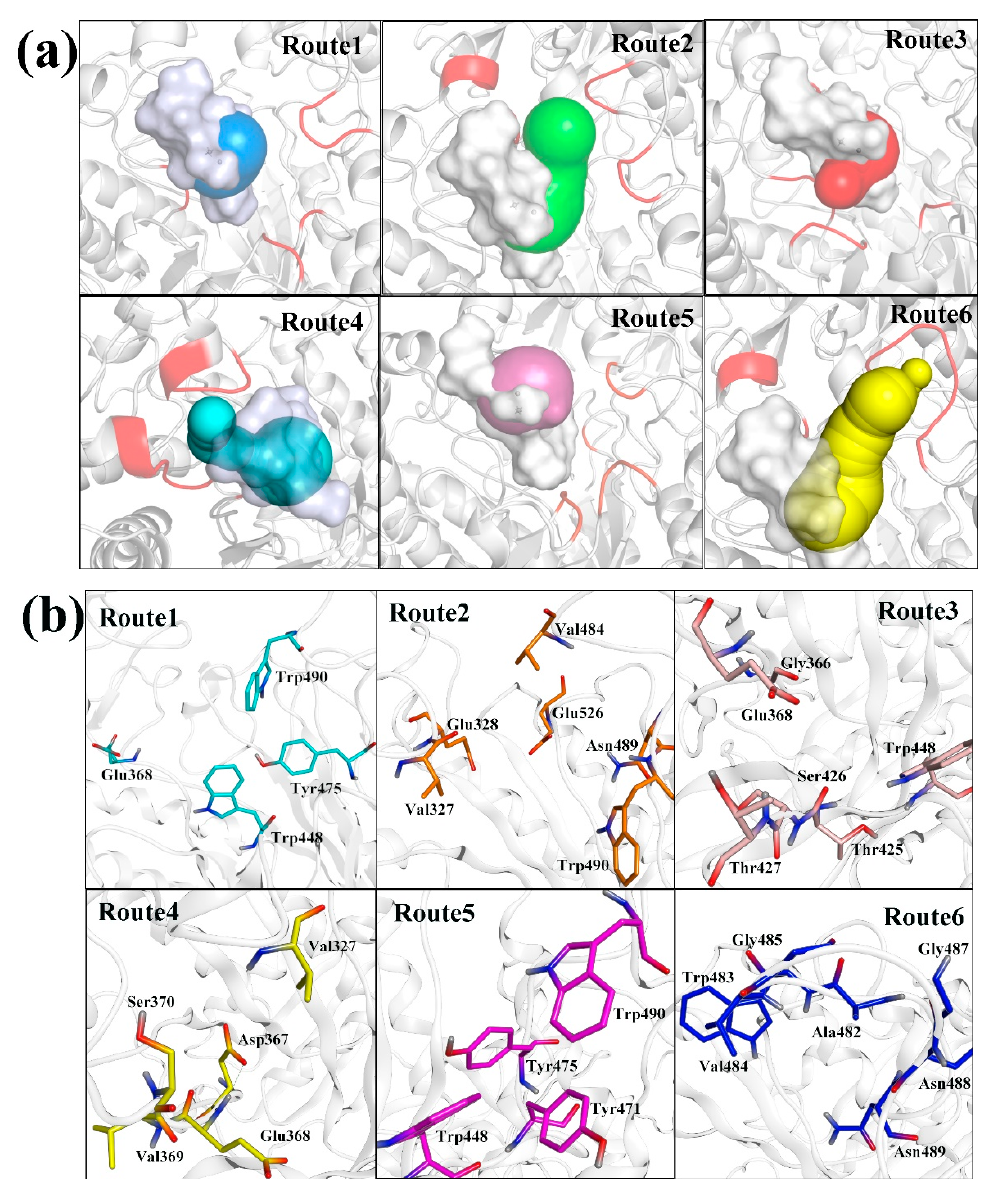
Figure 3. ( a ) Unbinding routes of TMG-chitotriomycin from O f Hex1 identified by CAVER from the last snapshot on the 125th nanosecond. ( b ) Residues of tunnels for Route 1, Route 2, Route 3, Route 4, Route 5, and Route 6.